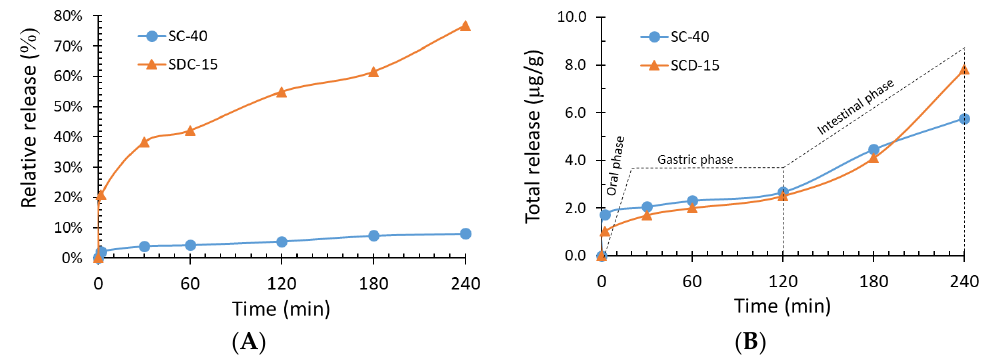
Figure 2. Relative ( A ) and total ( B ) release of carotenoids during simulated